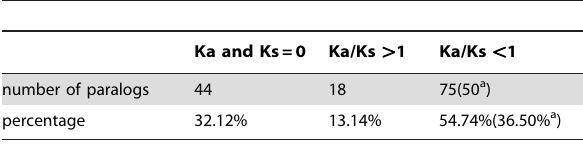
Table 1. The proportions of NDGs and parental genes with different